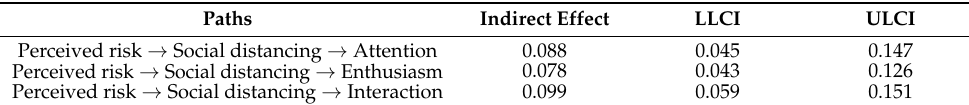
Table 5. Mediating effect analysis results ( n =